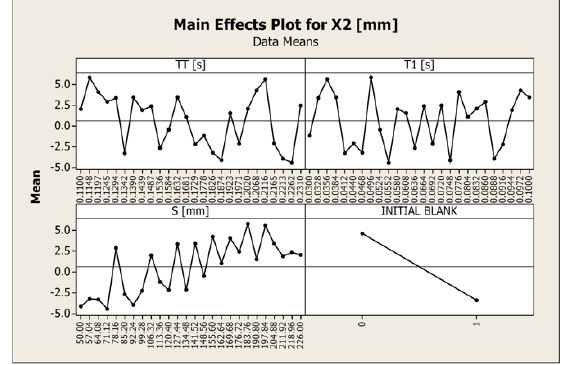
Figure 21. MEP for X2 output.